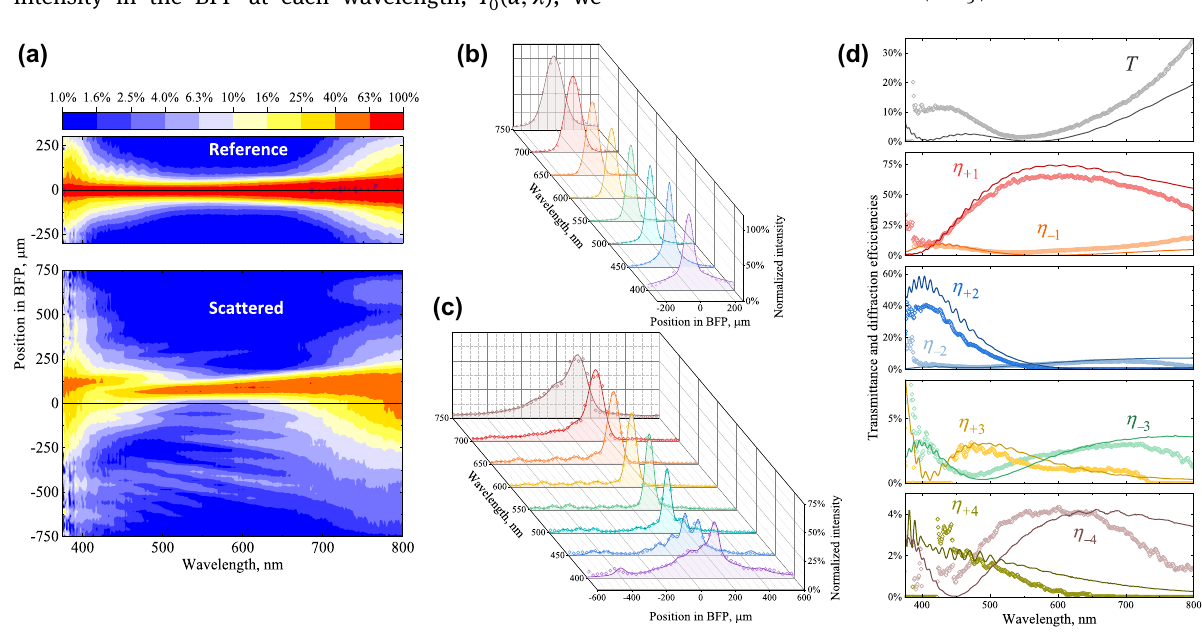
Figure 4: Extracting diffraction properties from the BFP-spectrometry data performed for the 8 𝜇 m periodic metasurface. (a) Intensity colormaps measured for the reference light transmitted by the homogeneous LC cell background and for the light scattered by the metasurface. Exemplary cross sections of the reference (b) and scattered (c) intensity colormaps with the measured intensity values shown by the circles and the lines displaying their analytical fits by Eqs. (2) and (1) in (b) and (c) respectively. Extracted spectra of transmittance and diffraction efficiencies are shown by circles in (d) compared to those predicted by numerical simulations (solid